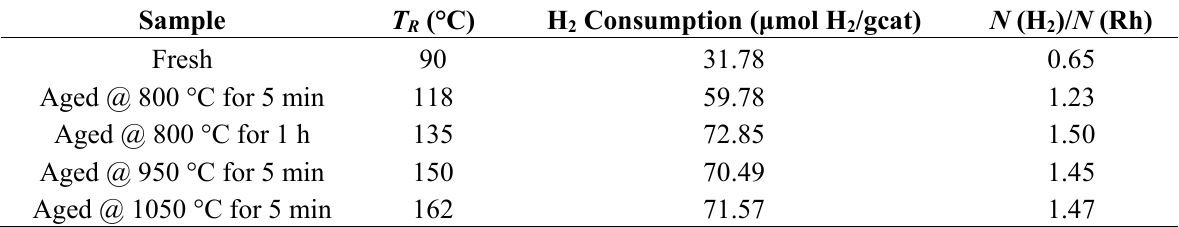
Table 5. Reduction temperature ( T R ) and H 2 consumption during H 2 -TPR for fresh and aged 0.5% Rh/Al 2 O 3